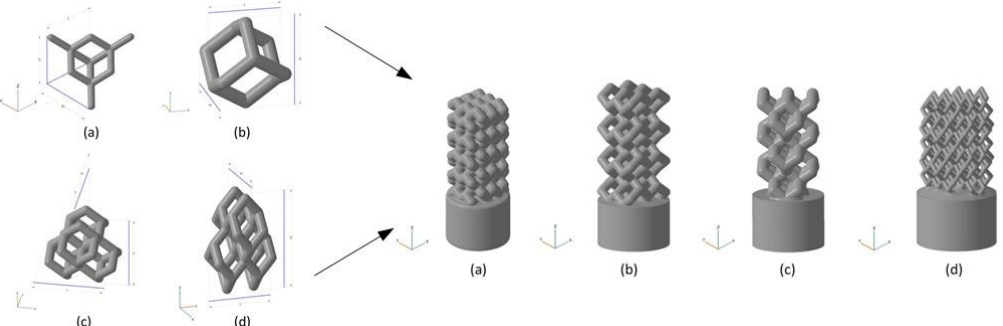
Figure 8. Unit cells used for implant modeling and the models of implants. Left: ( a ) UC001—the unit cell built on the basis of tetrahedral diamond structure (rib thickness = 0.4 mm, cell length (L) = 2.3 mm, cell width (W) = 2.3 mm, cell height (H) = 1.7 mm); ( b ) UC00202—the cell built on the basis of the UC001 unit cell by removing open ribs (rib thickness = 0.7 mm, L = 1.6 mm, W = 1.6 mm, H = 2.3 mm); ( c ) UC003—the cell built by replicating the UC002 unit cell along the X and Y axes by a factor of 2, with the offset along Z-axis by H/2, and along X-axis by W/2 (rib thickness of 0.7 mm, L = 3.5 mm, W = 3.5 mm, H = 3.8 mm); ( d ) UC004—the cell built by compressing the UC003 unit cell along X and Y axes by the factor of 2 (rib thickness =0.3 mm, L = 2.0 mm, W = 2.0 mm, H = 4.1 mm). Right: ( a ) BI001—the wireframe built by replicating the UC001 unit cell along three coordinate axes, by a factor of 3 along X and Y axes, and by a factor of 5 along Z-axis; ( b ) BI002—the UC002 unit cell is replicated by a factor of 2 along X and Y axes, and by the factor of 4 along Z axis; ( c ) BI003—the UC003 unit cell is replicated by a factor of 1 along X and Y axes, and by a factor of 3 along Z-axis; ( d ) BI004—the UC004 unit cell is replicated by a factor of 3 along X,Y, and Z axes [125].